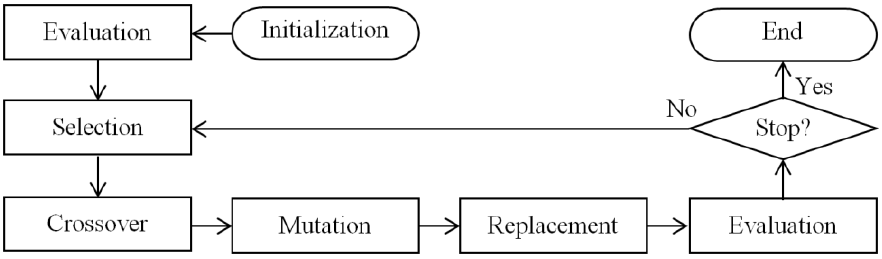
Figure 8. Flowchart of Genetic Algorithm with Maximum-Minimum Crossover (GA-MMC)